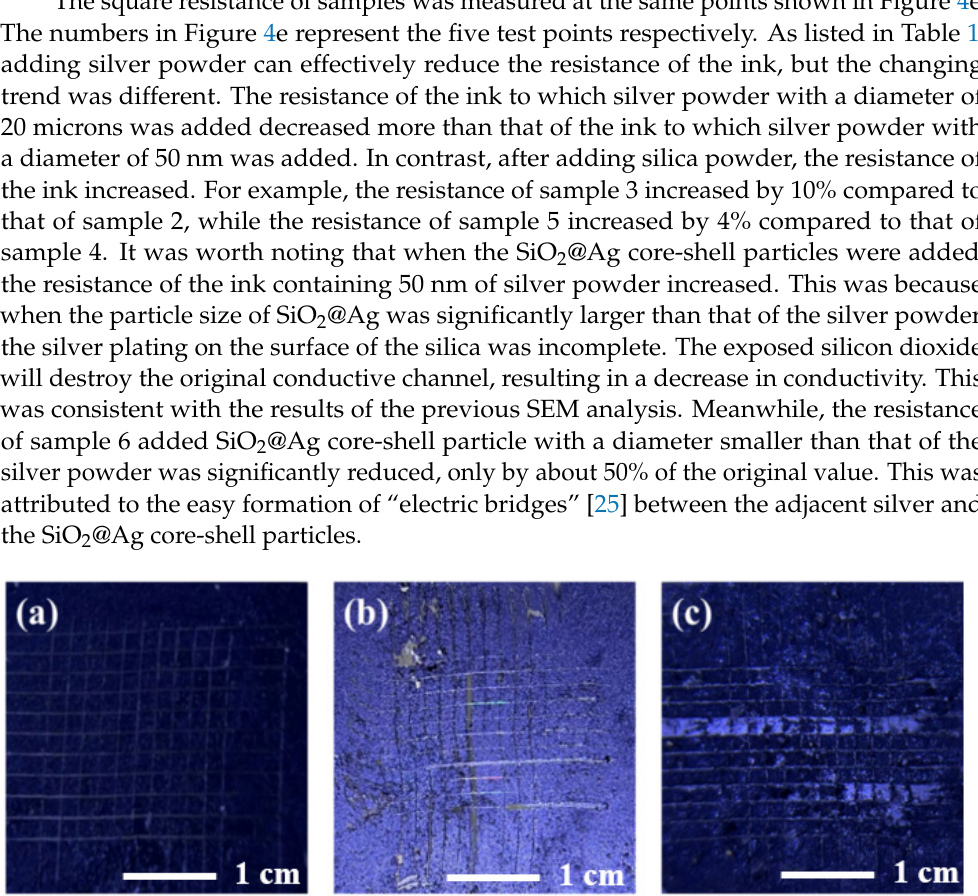
Figure 3. SEM images of modified samples 3 ( a ), 5 ( b ) and 6 ( c ).